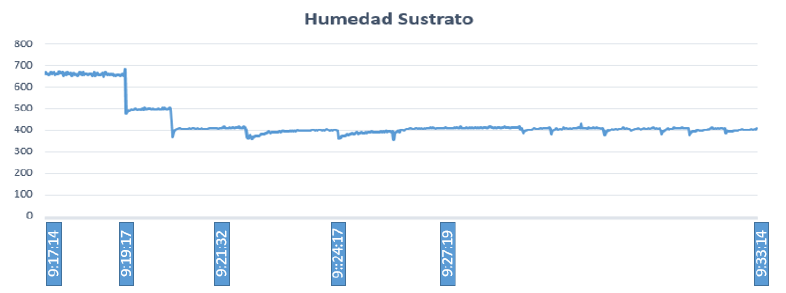
Figure 14. Substrate humidity variation.